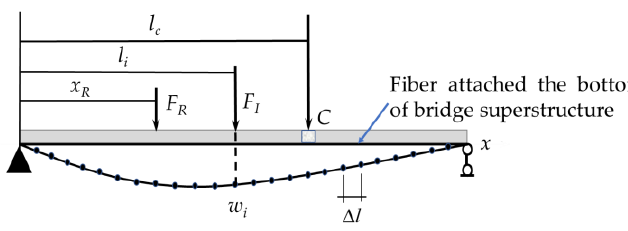
Figure 1. Schematic of the quasi-static loading of a bridge with a long sensing fiber.